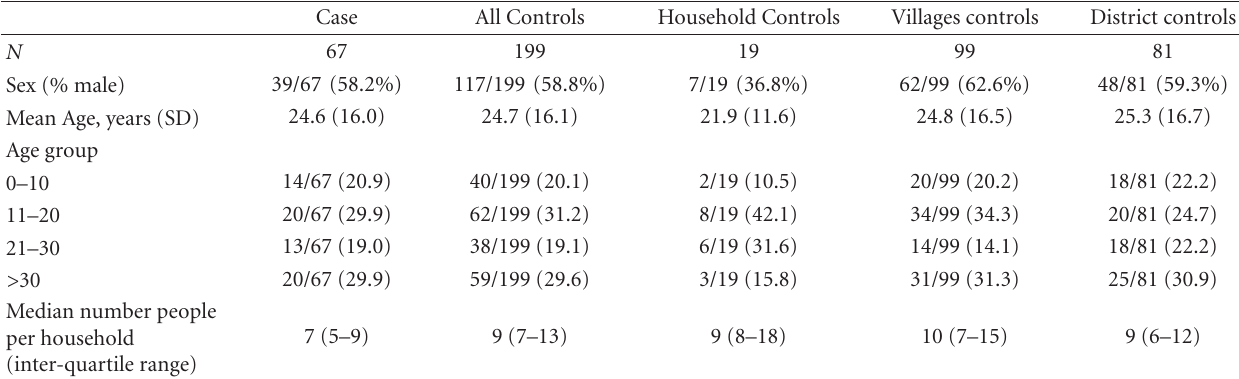
Table 1: Demographic characteristics of cases and